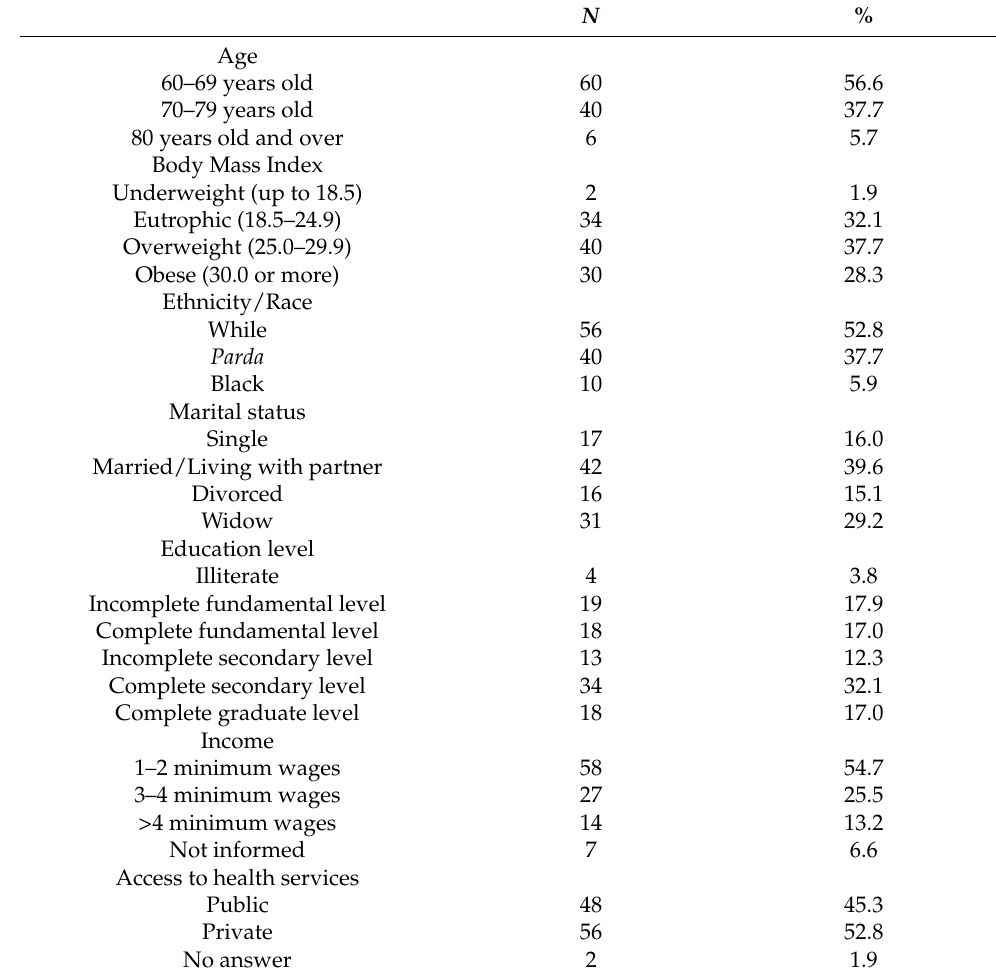
Table 1. Description of participants. Natal/Brazil, 2020.